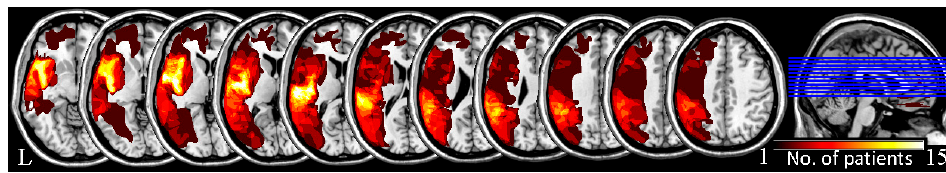
Figure 1. The lesion overlap images for all patients with aphasia.